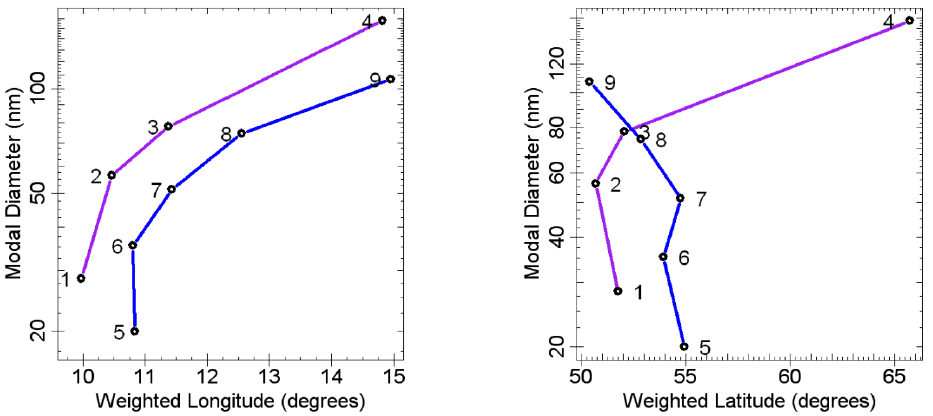
Fig. 7. Using the number distribution, the fitted modal diameter of each cluster (1–9) is plotted against the weighted longitude or latitude, . P 24 W i , where X i is the latitude/longitude of the sites where the cluster is detected calculated for each cluster, using WL = P 24 i W i · X i i and W i is the corresponding population of the cluster across the 24 sites. The purple (1, 2, 3 and 4) and blue (5, 6, 7, 8 and 9) colours depict two aggregated trends observed in the data based on a South to North and West to East air mass movement.